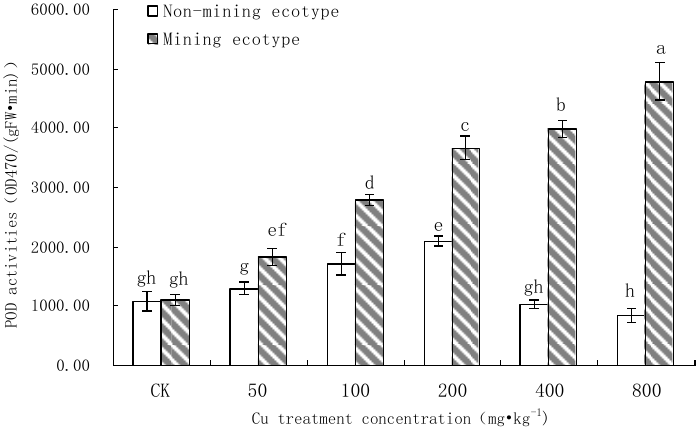
Figure 7. Activity of POD of two ecotypes of M. floridulus under different Cu treatment. Note: Error bars indicate standard deviation; Different letters in the same group indicate significant difference at p < 0.05 according to Duncan’s multiple range tests; the same below.